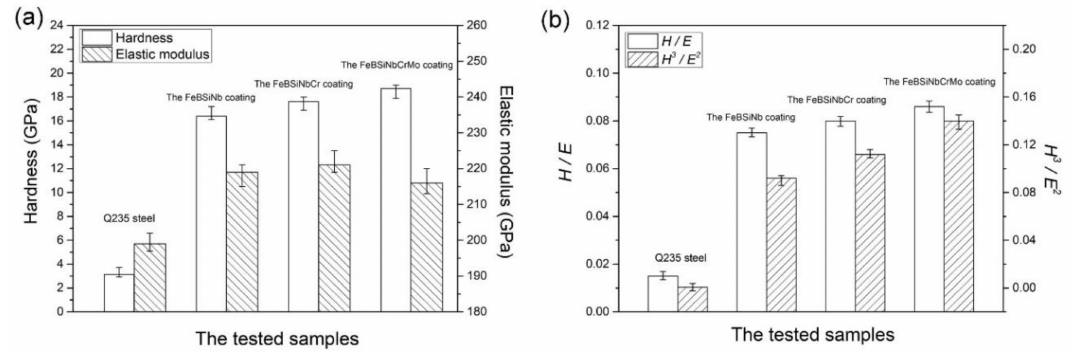
Figure 5. ( a ) Hardness H and elastic modulus E , ( b ) H / E and H 3 / E 2 of the samples. Reprinted with permission from ref. [68]. Copyright 2018